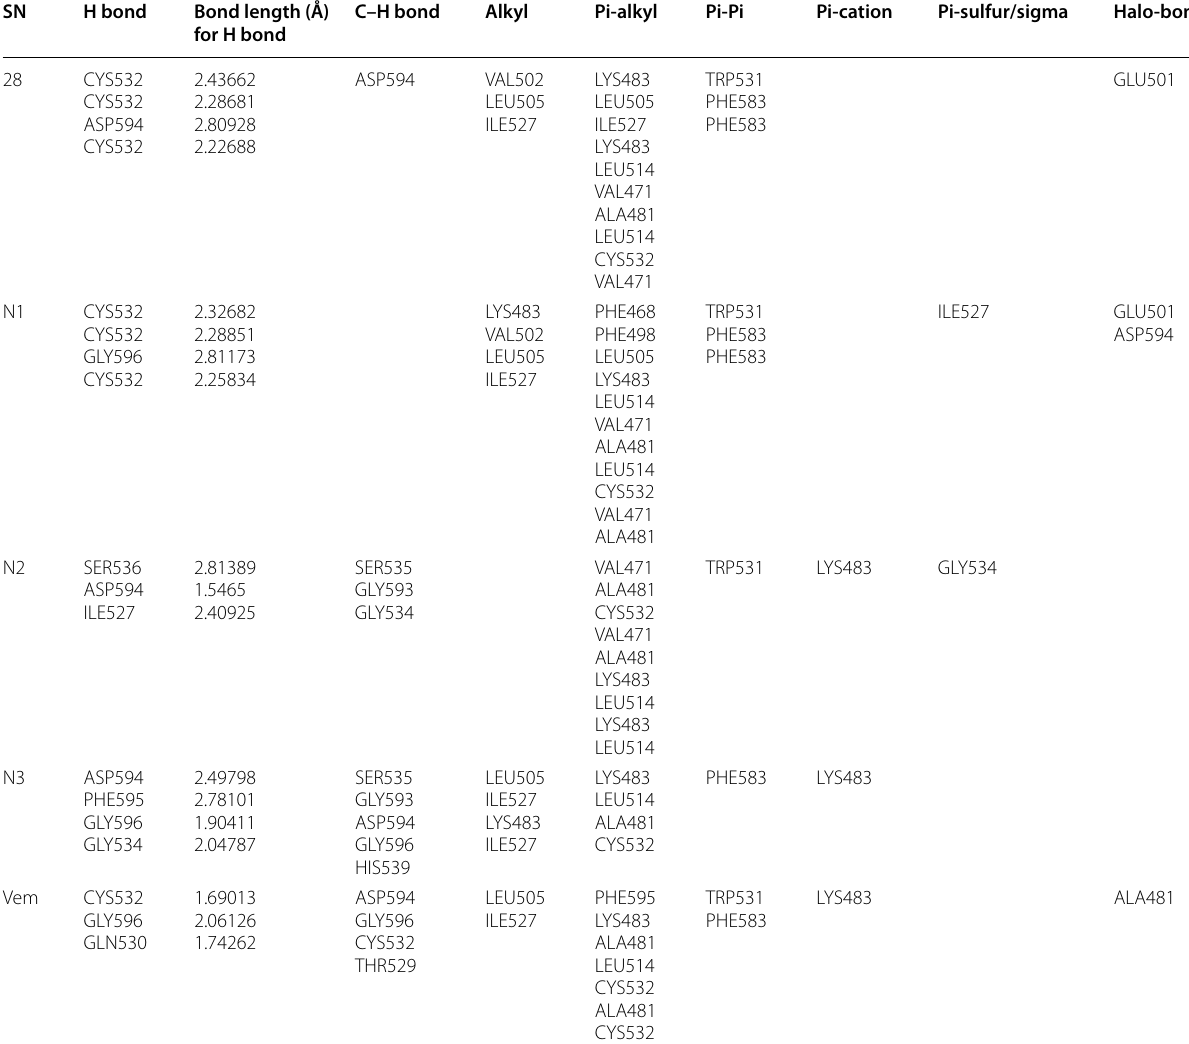
Table 2 Molecular interactions present in the docked poses and the amino acids involved SN H